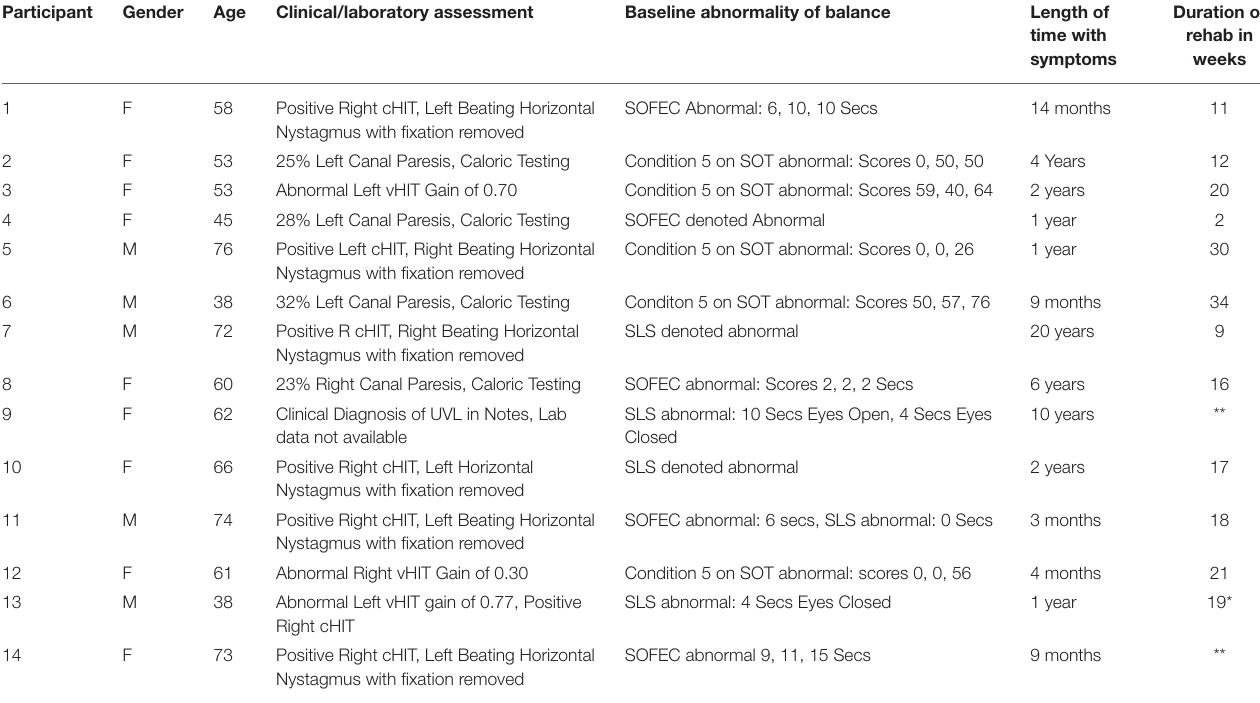
TABLE 1 | Participant baseline clinical